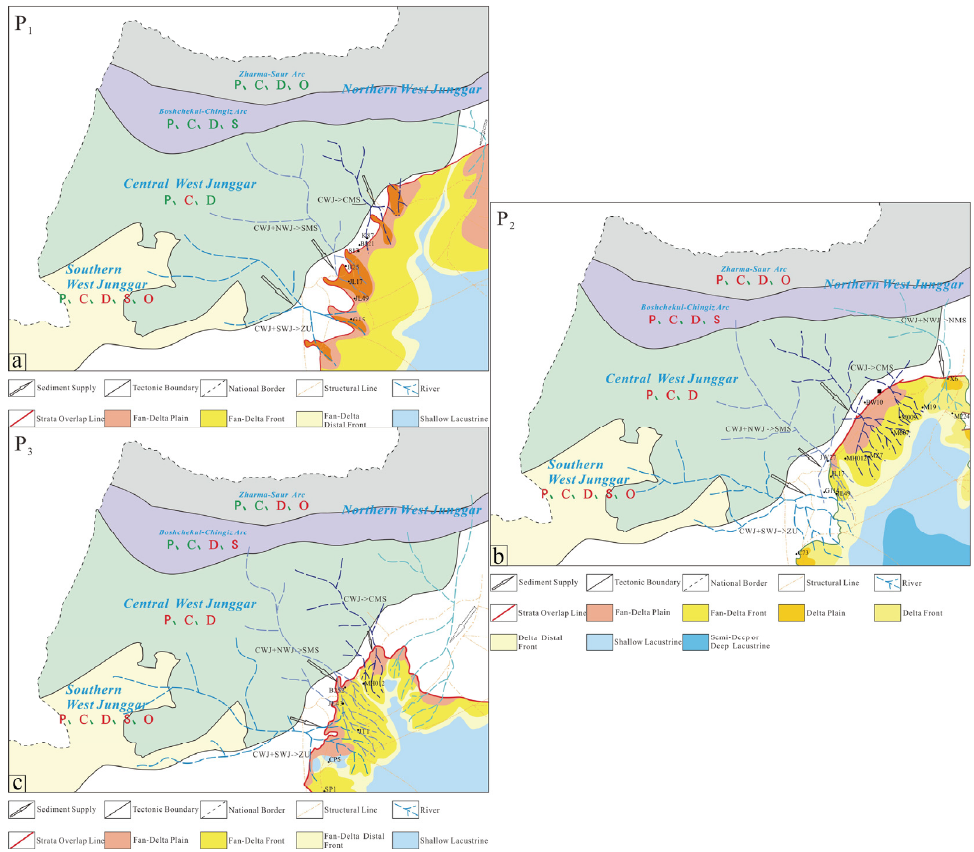
Figure 11. Schematic diagram of the distribution of the source-to-sink systems during the ( a ) Early Permian, ( b ) Middle Permian and ( c ) Late Permian in the Mahu-Zhongguai area, northwestern Junggar Basin. CWJ + NWJ → NMS: The source-to-sink system with central West Junggar (CWJ) and northern West Junggar (NWJ) as the main provenances and the northern Mahu Sag (NMS) as the depositional area. CWJ → CMS: The source-to-sink system with CWJ as the provenance and the cen- tral Mahu Sag (CMS) as the depositional area. CWJ + NWJ → SMS: The source-to-sink system with CWJ and NWJ as the main provenances and the southern Mahu Sag (SMS) as the depositional area. CWJ + SWJ → ZU: The source-to-sink system with CWJ and southern West Junggar (SWJ) as the provenances and the Zhongguai Uplift (ZU) as the depositional area. The green capital letters indi- cate the potential parent rock ages in each unit; the red capital letters indicate the possible strati- graphic age to provide the sediments in the area. The distribution map of sedimentary facies was prepared by the Xinjiang Oilfield Company. Note: The Upper Permian series in the NMS was eroded, and relevant data of the lower Permian series was lacking. Therefore, the CWJ + NWJ → NMS systems in the Early and Late Permian were all results speculated according to the inheritance of the source-to-sink systems and are represented by dashed lines in the figure. 1. Jiamuhe Formation During the depositional period of the Jiamuhe Formation, the source-to-sink systems of the SMS and the ZU differed greatly (Figure 11a). The source of detritus in the SMS system was relatively simple, mainly the Early Carboniferous zircons from CWJ. The source of detritus in the ZU system was mainly the Carboniferous magmatic rocks in CWJ, with a small portion of mixed Silurian-Devonian supply from SWJ. 2. Fengcheng Formation During the Fengcheng Formation’s depositional period, the CMS system’s prove- nance was relatively simple, mainly the Carboniferous series in CWJ. The SMS system was dominated by proximal Carboniferous detrital sediment supply from CWJ, and the presence of Silurian zircon marked the distal sediment supply from NWJ (Figure 11a).